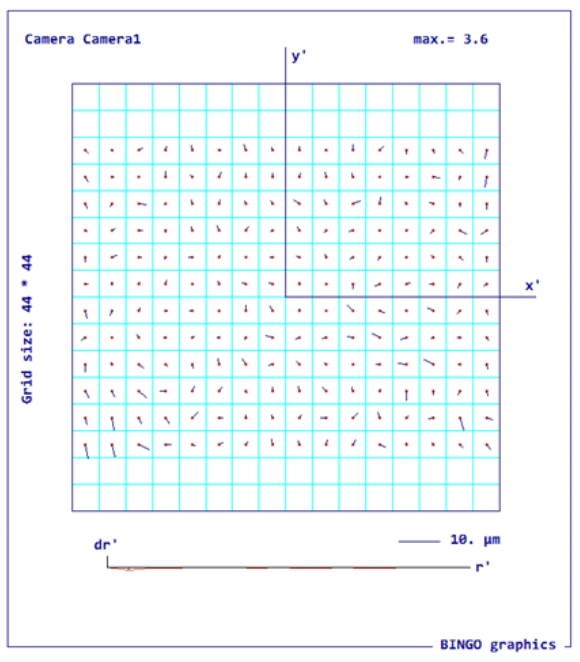
Figure 5. The remaining errors and their directions can be seen on a selected